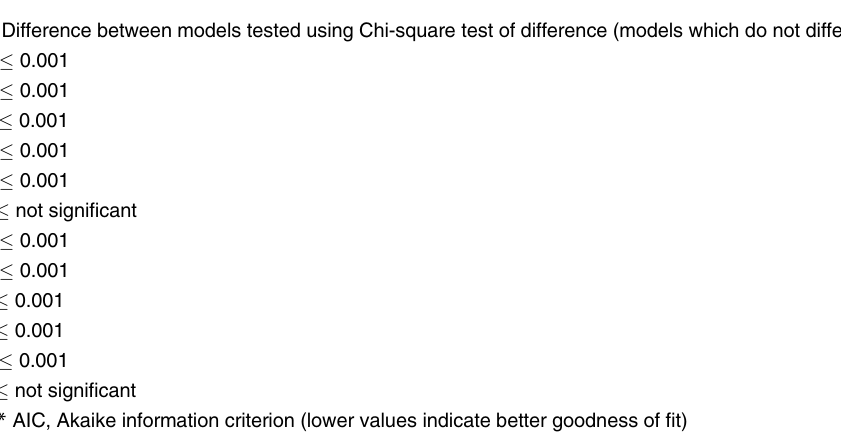
* Difference between models tested using Chi-square test of difference (models which do not differ or differ less are more similar to each other). a (cid:1) 0.001 b (cid:1)